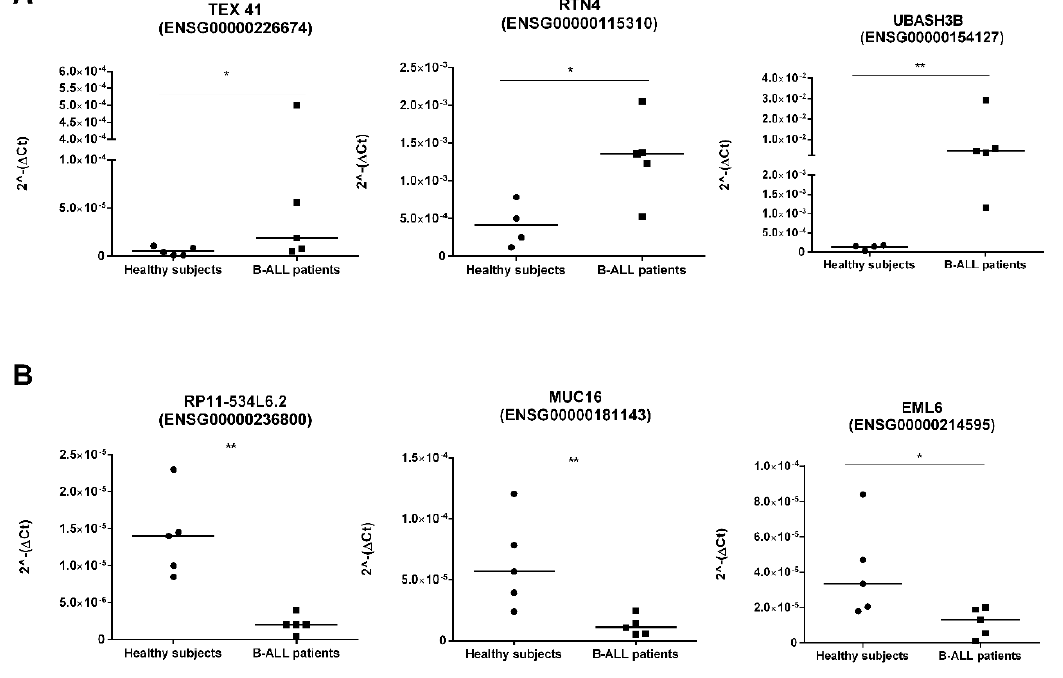
Figure 5. Expression level of the indicated lncRNA–mRNA pairs in healthy naive B cells ( n = 5) and leukemic cells derived from paediatric B–ALL patients ( n = 5). ( A ) lncRNA TEX41 and its co–expressed mRNAs (RTN4 and UBASH3B). ( B ) lncRNA RP11_534L62 and its co–expressed mRNAs (MUC16 and EML6). The relative expression level was determined using the 2 − ∆ Ct method and shown